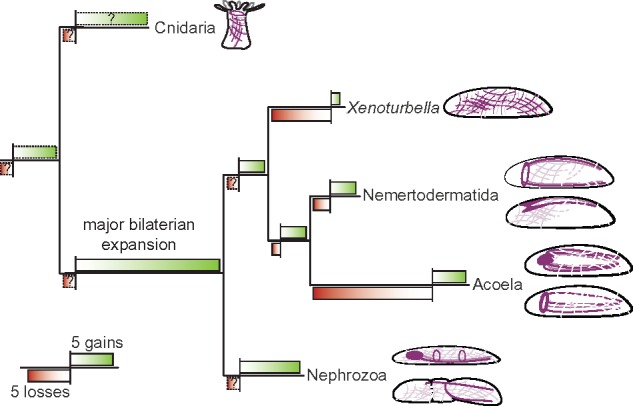
Changes in the complement of peptidergic systems during bilaterian evolution. Tree shows major expansion of peptidergic systems in the ancestral bilaterian lineage followed by clade-specific changes in sublineages. Bars show number of changes as detected losses (red bars underneath the branches) and detected gains (green bars above the branches) of peptidergic systems in the corresponding lineage. Length of bars are estimated based on the results of this study, with 4–5 peptidergic systems in the cnidarian–bilaterian ancestor that gave rise to the main diversification in the bilaterian lineage (excluding relaxin GPCRs and GPH GPCRs). The two bars on the lower left side indicate the bar-length for five gains or five losses. Cartoons depict simplified examples of nervous system anatomies (purple) from representative taxa (top to bottom: anthozoan, Xenoturbella bocki, Nemertoderma westbladi, Meara stichopi, Isodiametra pulchra, Dipisthoporus longitubus, annelid, and hemichordate).